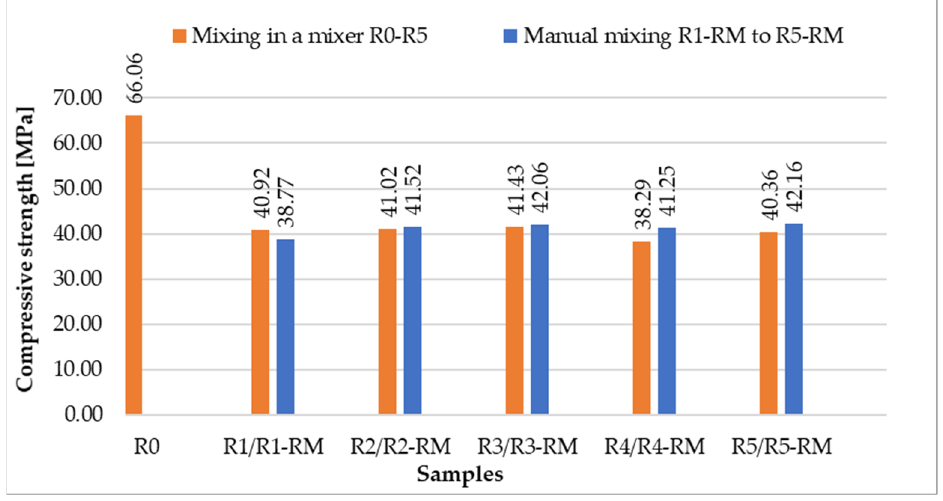
Figure 12. Comparison of compressive strengths after 28 days for samples mixed in a mixer and mixed manually. mixed